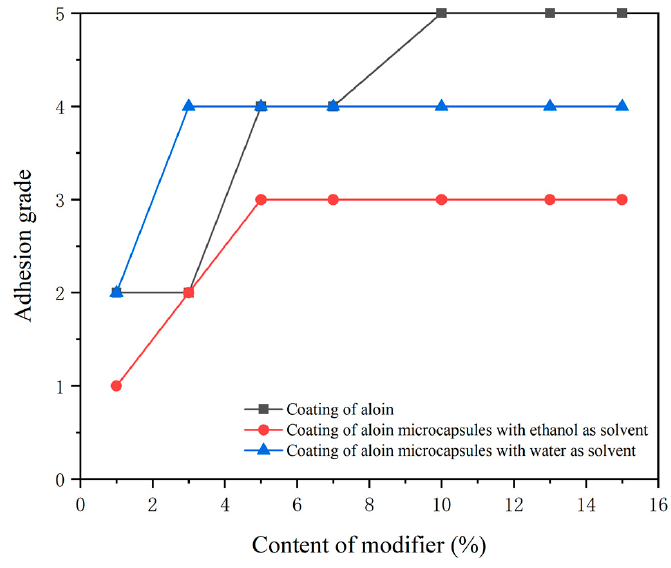
Figure 6. Adhesion of coatings with different content of modifiers.